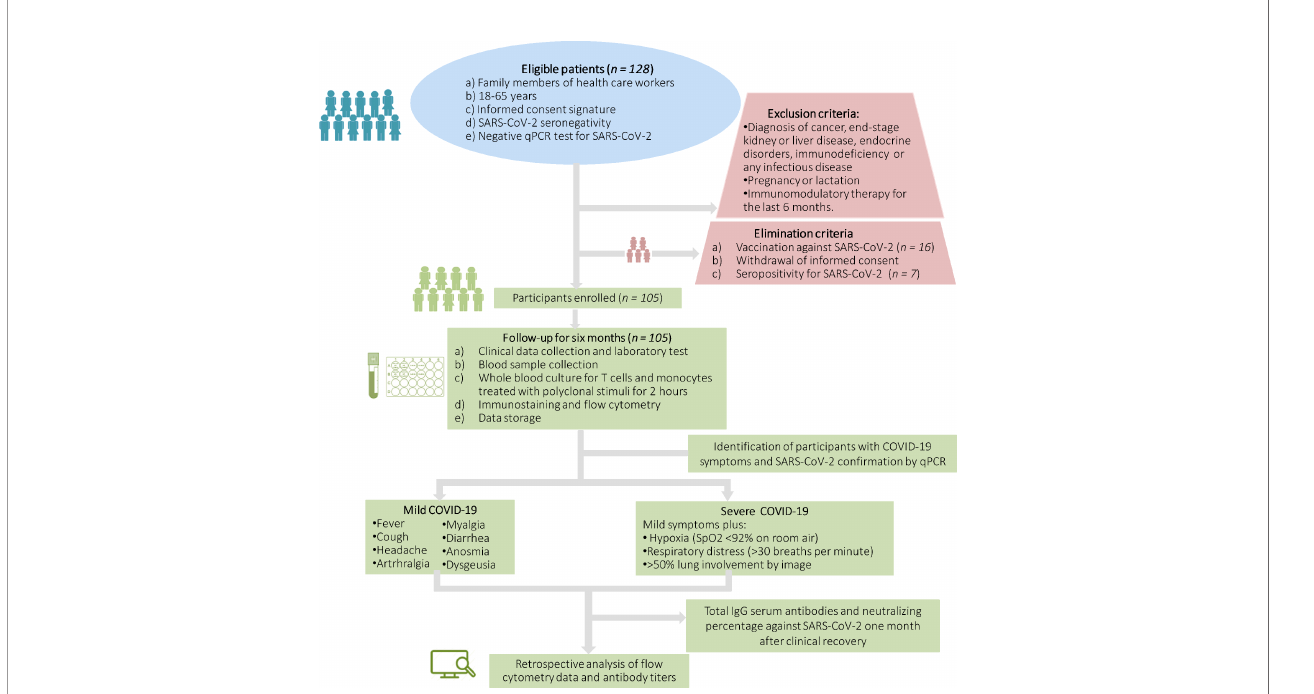
FIGURE 1 | Schematic fl ow chart showing the selection process of eligible participants. SpO2, oxygen saturation level; SARS-CoV-2, severe acute respiratory syndrome coronavirus type 2; qPCR, quantitative polymerase chain reaction; COVID-19, coronavirus disease